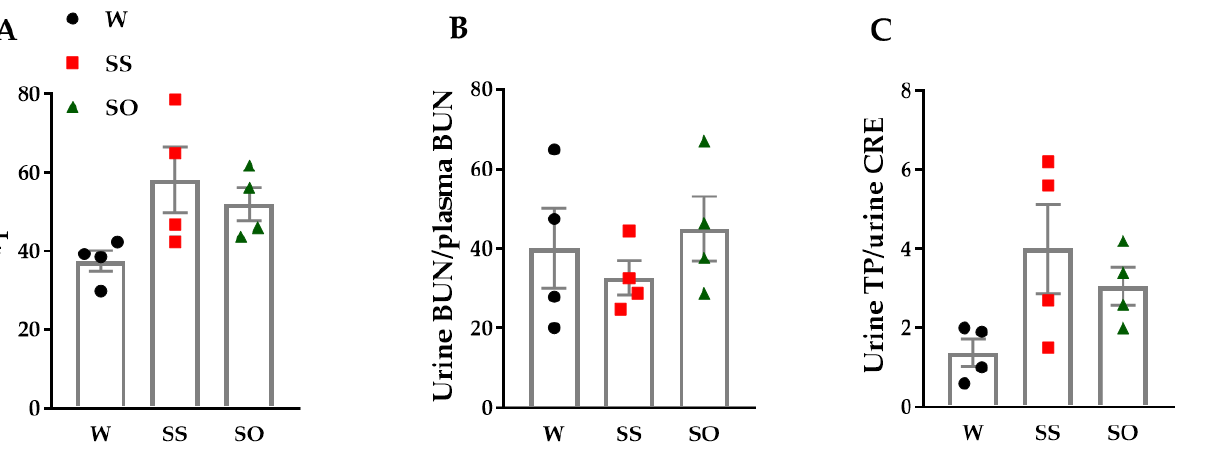
Figure 6. Renal dysfunction in SHR tended to be improved by human omentin-1. Heparin- anticoagulated plasma and urine were collected from male SHR (65–68-week-old) subcutaneously injected with saline (0.14 mL/day, n = 4; SS) and human omentin-1 (18 µ g/kg/day, n = 4; SO) by using an implanted osmotic pump for 14 days or sham operated WKY (n = 4; W). Urine was collected by placing rats in a metabolic cage for 24 h. Blood urea nitrogen (BUN, mg/dL) and creatinine (CRE, mg/dl) in plasma and urine were measured with Wet Chemical Analysis. Urine total protein (TP) concentration (mg/mL) was measured with a BCA Protein Assay. ( A ) Plasma BUN/plasma CRE, ( B ) Urine BUN/plasma BUN, and ( C ) Urine TP/urine CRE were calculated. Results were expressed as means ± S.E.M. Statistical evaluations were performed using One-way ANOVA followed by Bon- ferroni’s post -hoc test.